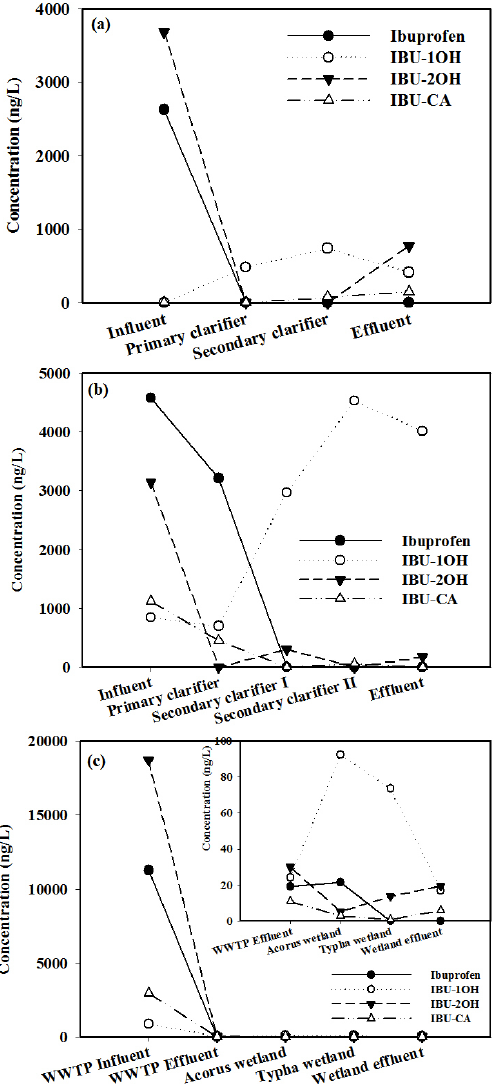
Figure 2. Distribution of carbamazepine metabolites in di ff erent WWTPs system: (a) Gwangju primary WWTP, (b) Gwangju sec- ondary WWTP, (c) Damyang WWTP and constructed